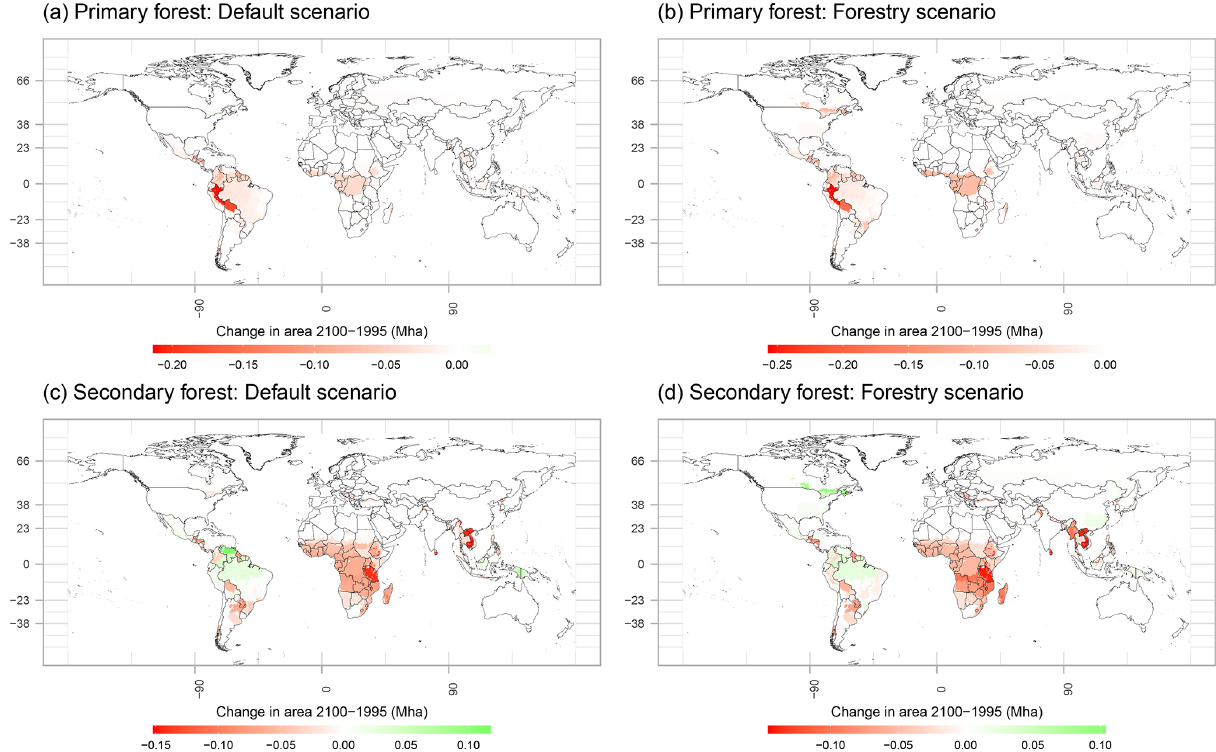
Figure A2. Natural forest area difference between 2100 and 1995 in the default and forestry